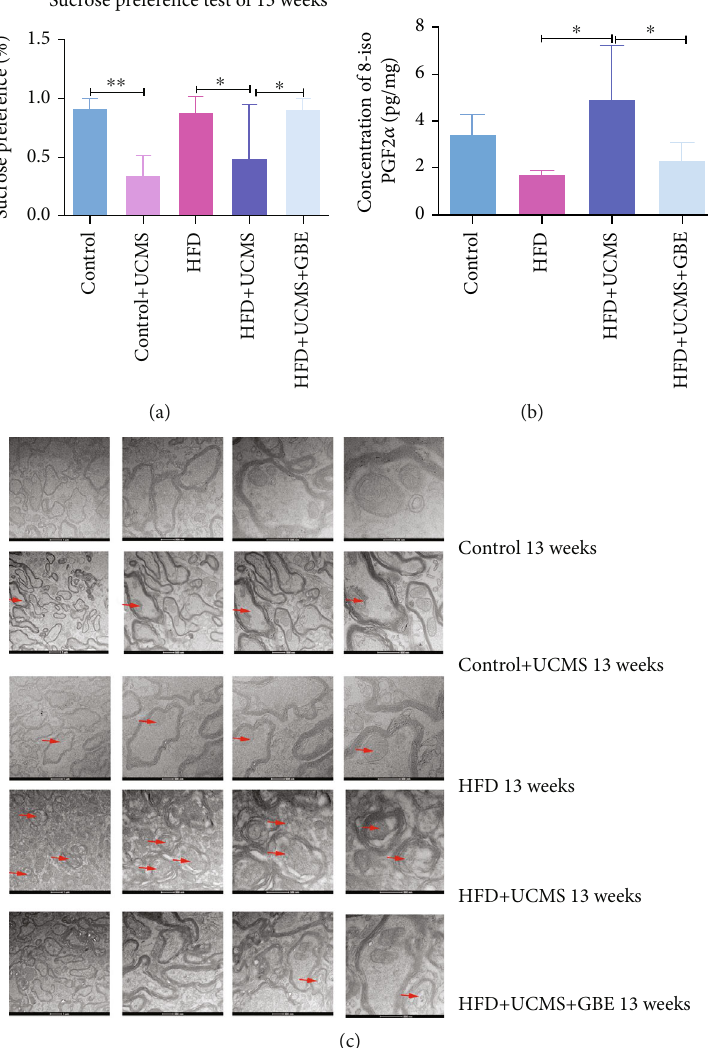
Figure 7: Depressive behavior and hippocampus and cortex in fl ammation. (a) Detection of depressive behavior by sucrose preference test; (b) the concentration of cortex 8-iso-PGF2 α ; (c) TEM demonstrating normal control tissue and treated tissue illustrating neuronal injury; the arrows show mitochondrial injuries in the hippocampus; scale 1 μ m and 500 nm; TEM: Transmission Electron Microscope. n = 5 rats per group; ∗ P < 0 : 05 ; ∗∗ P < 0 : 01 ; ∗∗∗ P < 0 : 001